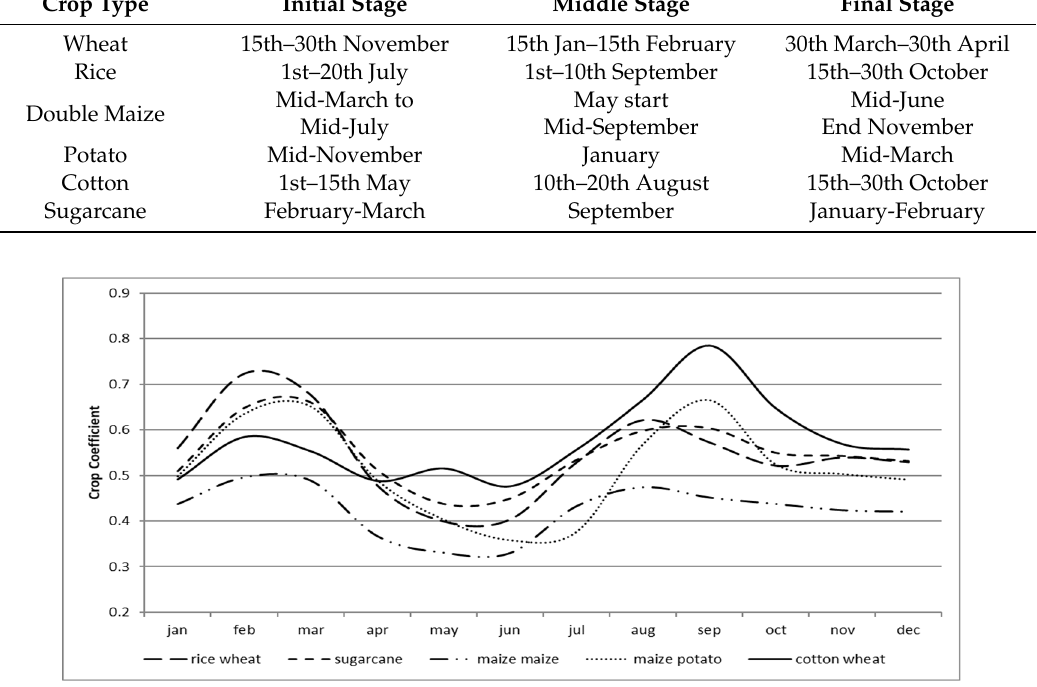
Figure 10. Crop coefficients of various crops for a crop calendar. Figure 10. Crop coe ffi cients of various crops for a crop